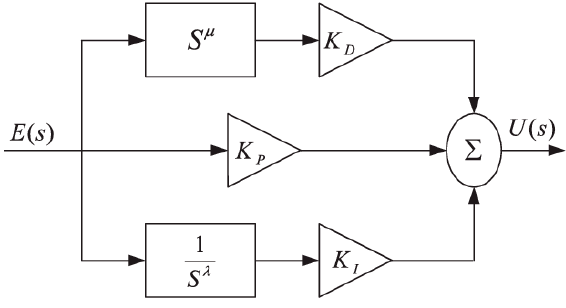
Figure 7. The FOPID controller structure.